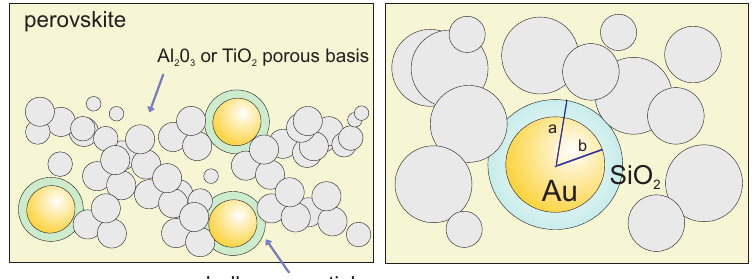
Figure 1. The spherical Au nanoparticles with radius b 40 nm coated with the dielectric layer of ∼ SiO 2 of final radius a 48 nm are embedded in the perovskite layer of the chemical perovskite solar ∼ cell. Core–shell plasmonic nanoparticles are located in pores of Al 2 O 3 or Ti0 2 porous basis with a low = N density of particles, n = N , corresponding to ca. 1 wt % of porous basis, where N is the number V SH of plasmonic nanoparticles, S is the surface of the perovskite layer and H is its depth (experiment in Ref.